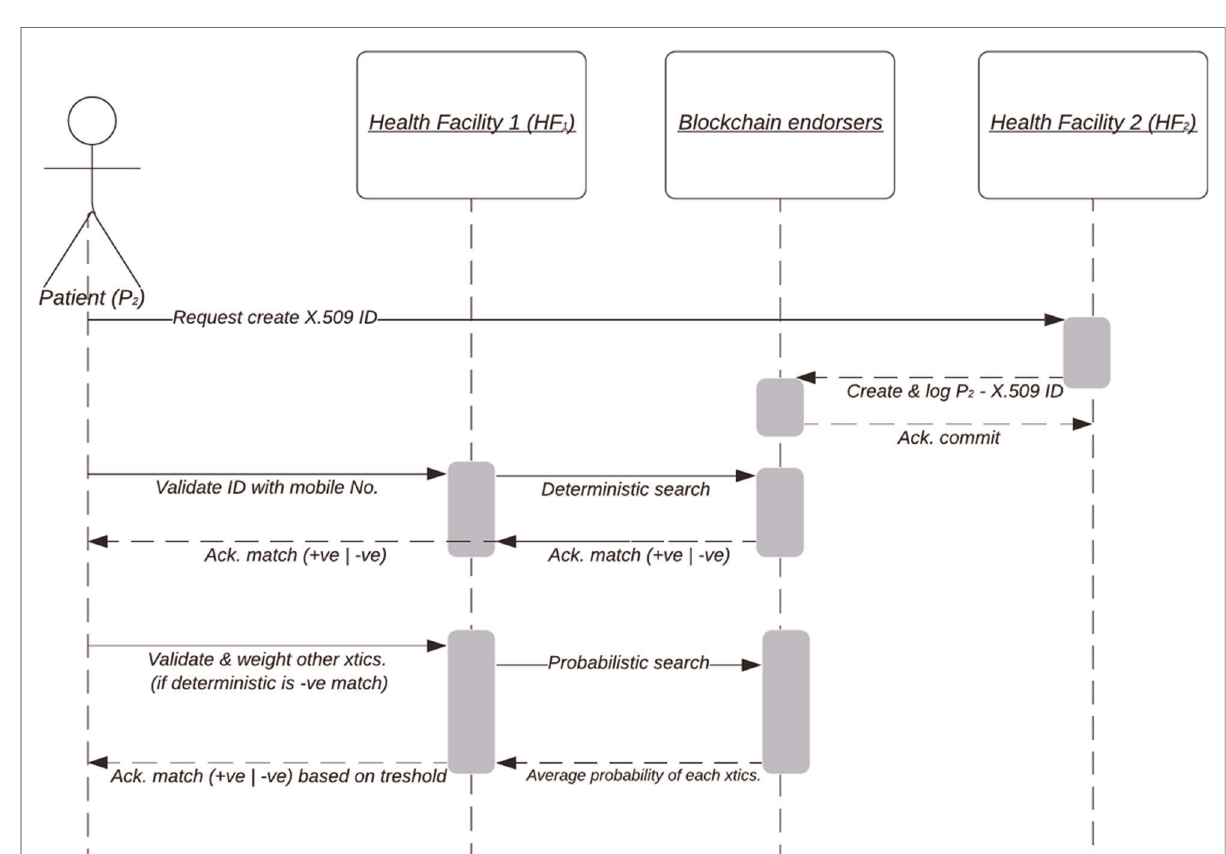
FIGURE 5 Sequence diagram showing proposed patient ID registration and matching